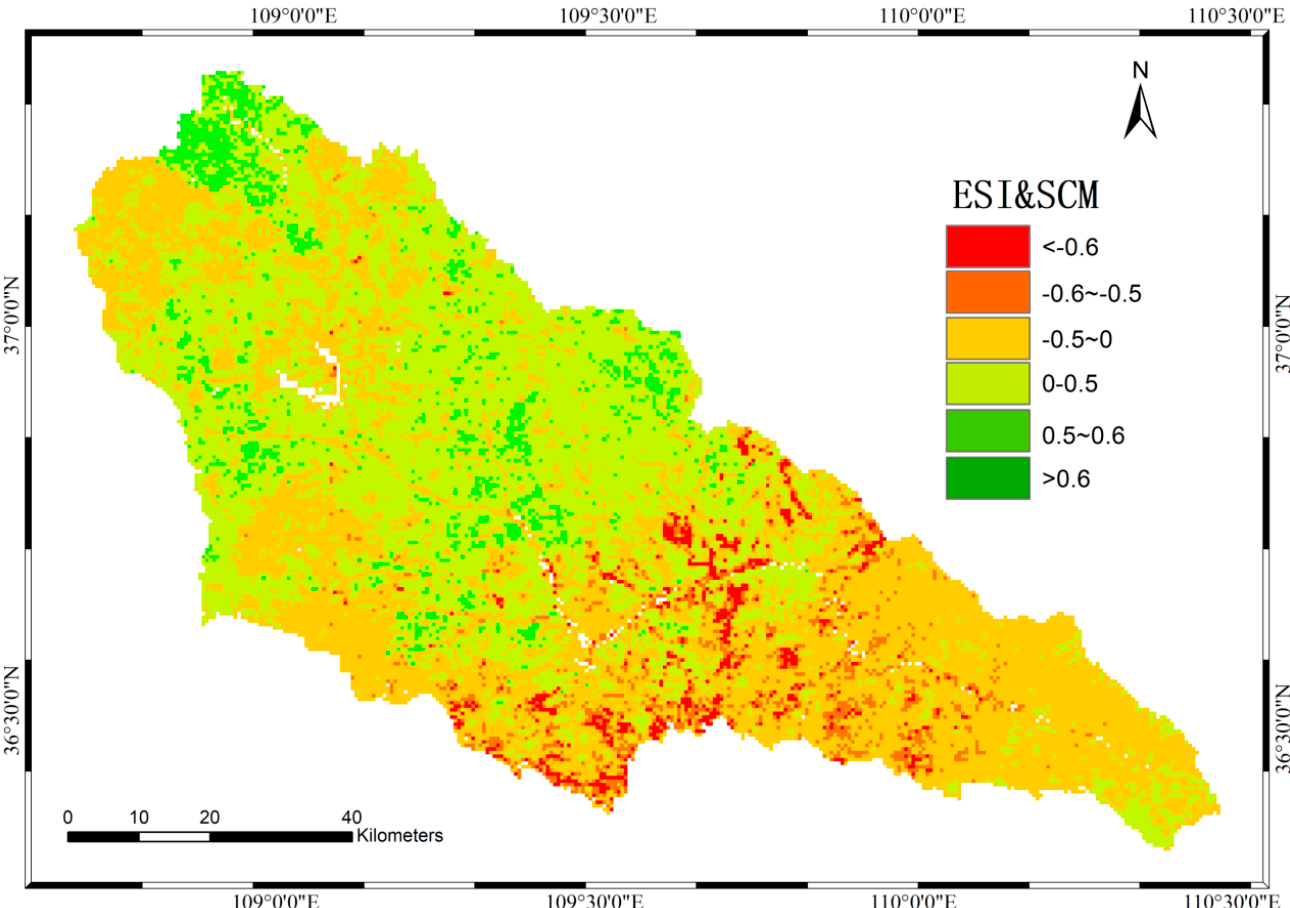
Figure 9. Spatial correlation coefficient between SCM and ESI.